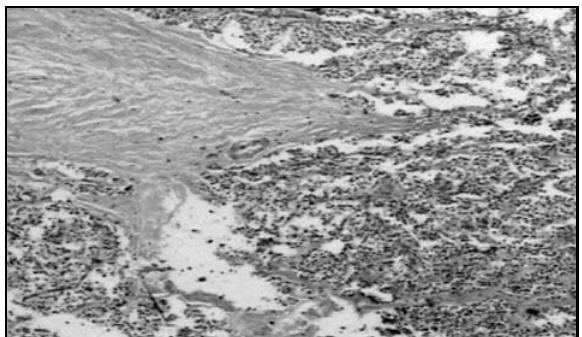
Figura 3 – Adenoma de paratireóide (HE 10x)